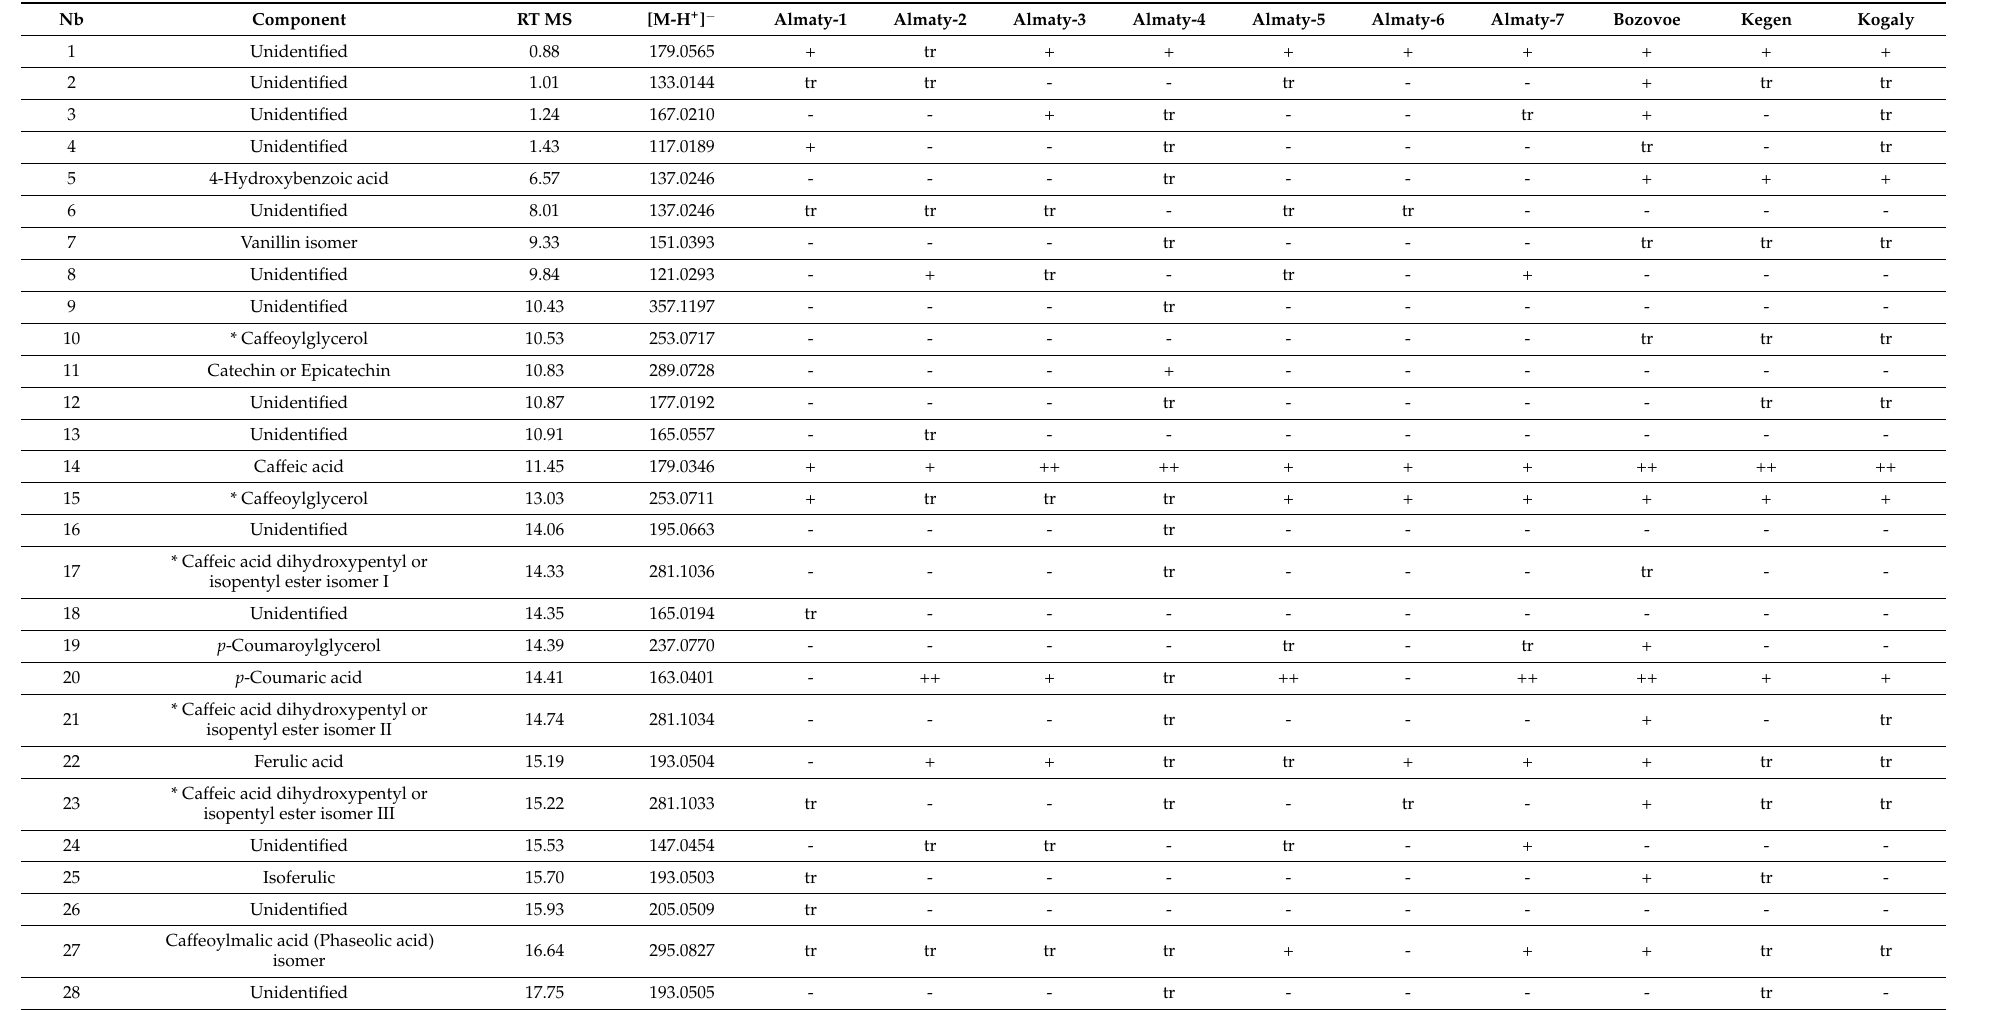
Table 2. Relatively presence of main propolis components in UHPLC-MS/MS chromatograms of 70EEP from